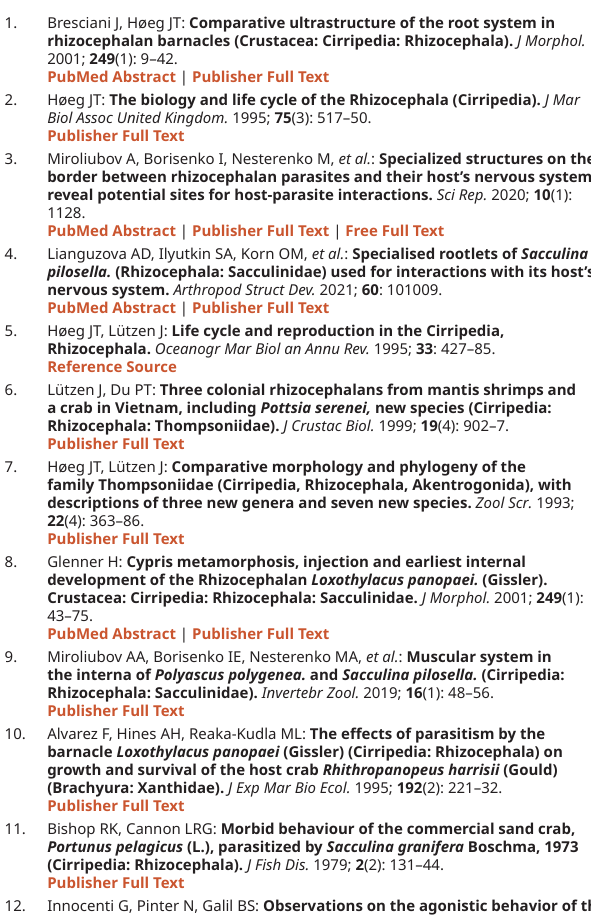
Figshare: Table S7. Evolutionary transcriptomics results,